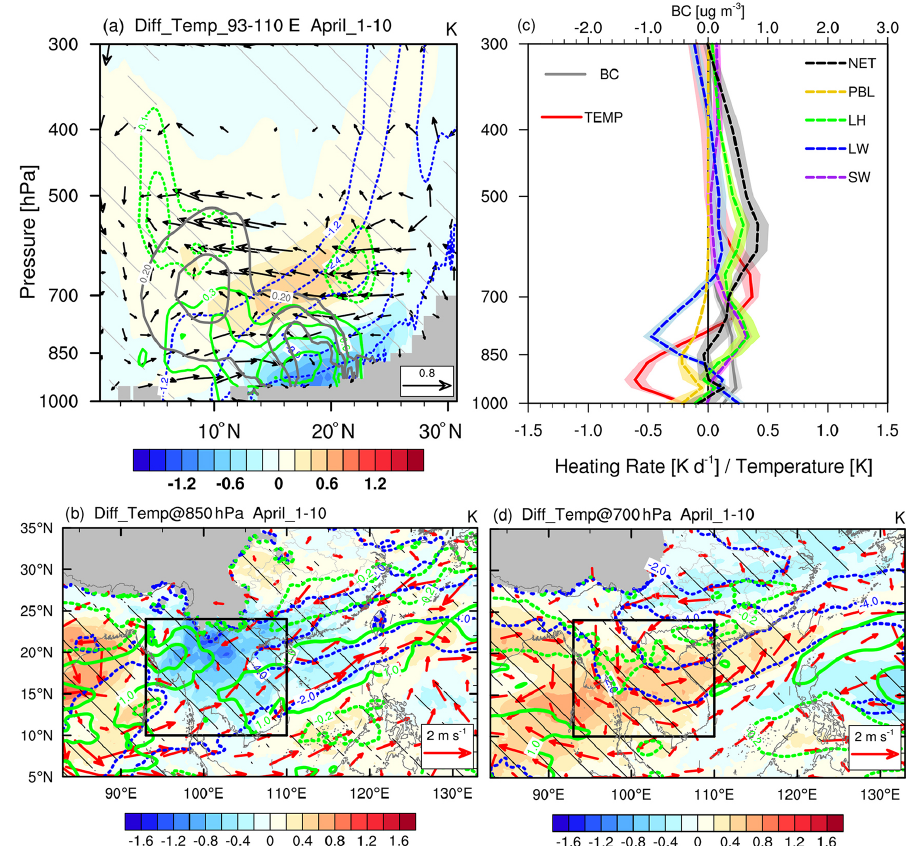
Figure 12. (a) Vertical cross sections of differences (CTRL minus BBER) in temperature (shading; K), geopotential height (blue contours with an interval of 1.2dagpm; the dashed contours are for negative values, and the zero contour is omitted for clarity), and water-vapor content (green contours with intervals of 0.3gkg − 1 for positive values and 0.1gkg − 1 for negative values, and the zero contour is omitted for clarity) together with meridional and vertical velocity (vector; ms − 1 and 10 − 2 ms − 1 , respectively) and BC mass concentration (solid grey contours with an interval of 0.2µgm − 3 ) averaged over 93–110 ◦ E. (b) Differences (CTRL minus BBER) in 850hPa wind (vector; ms − 1 ), geopotential height (blue contours with an interval of 1.2dagpm), water-vapor content (green contours with intervals of 1.0gkg − 1 for positive values and 0.2gkg − 1 for negative values, and the zero contour is omitted for clarity), and temperature (shading; K). (c) Vertical profiles of differences (CTRL minus BBER) in temperature (solid red line; K), BC mass concentration (solid grey line; µgm − 3 ), and atmospheric heating rates (dashed lines; Kd − 1 ) averaged over the ICP (black box in panel b ). (d) Same as (b) but at 700hPa. Shading in panel (c) denotes a single standard deviation of temperature, BC mass concentration, and atmospheric heating rate. Hatching and the vector denote the shaded field, and wind changes are statistically significant at the 95% confidence level, respectively, based on a Student’s t test. All of them are averaged over 1–10 April 2010 (i.e., early